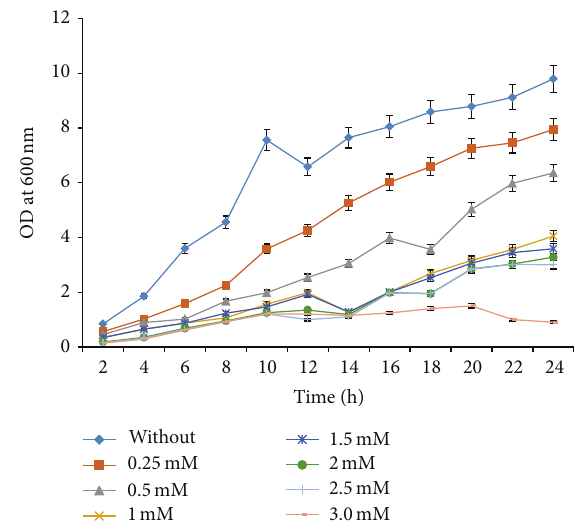
Figure 2: Effect of methionine on the growth pattern of ERG9 repressed yeast strain (YCF-005) cultivated in shake flasks contain- ing minimal medium and 20 g/L glucose (average data obtained from triplicate of the experiments were